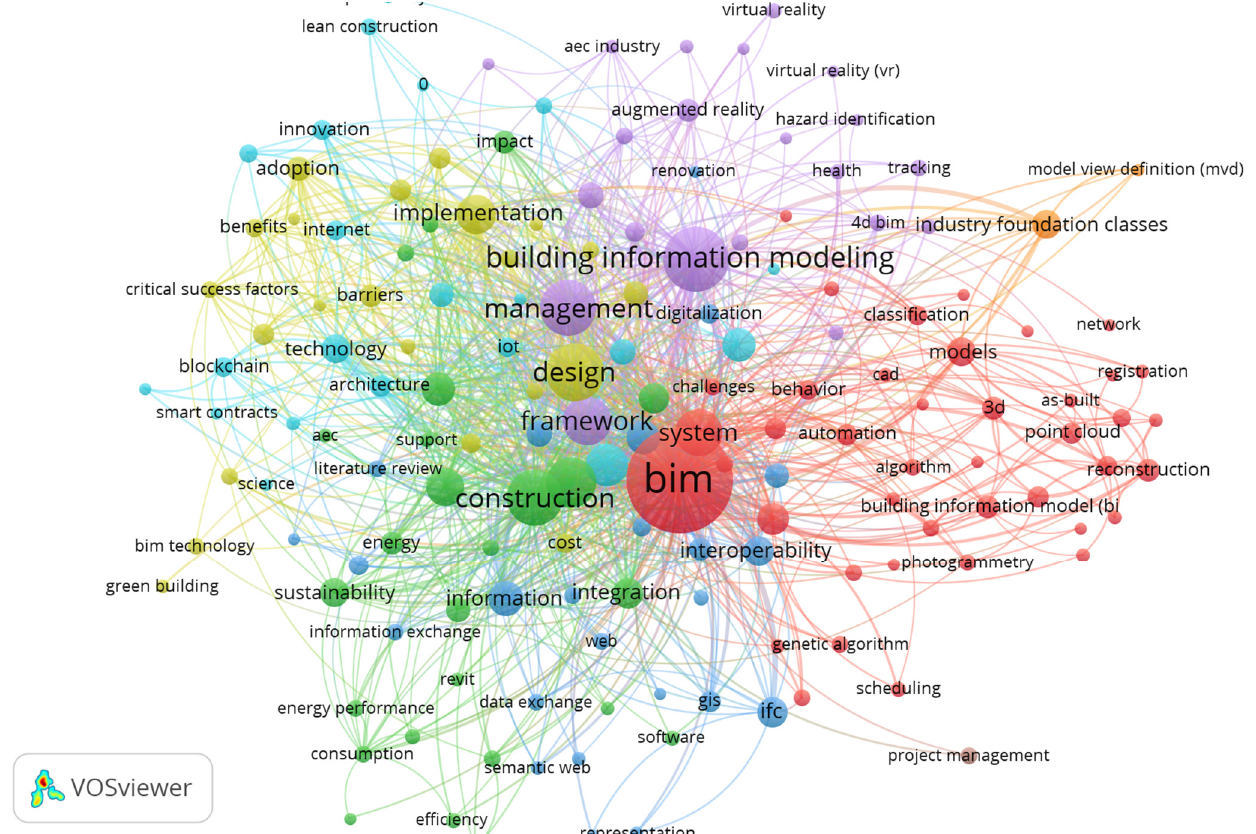
Figure 5. Keyword co-occurrence network.